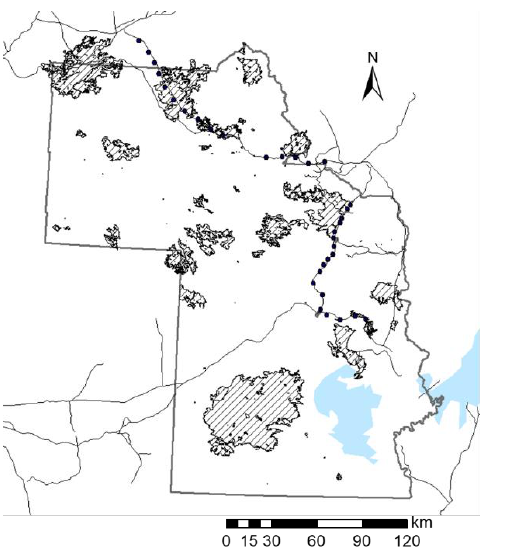
Figure 1. The study site with Terrestrial Lidar Scanning (TLS) locations denoted by ● . The thin black lines are roads and the shaded polygons are recently burned areas (within the last 3 years). To the right, panoramic views of TLS point clouds of different fire conditions.